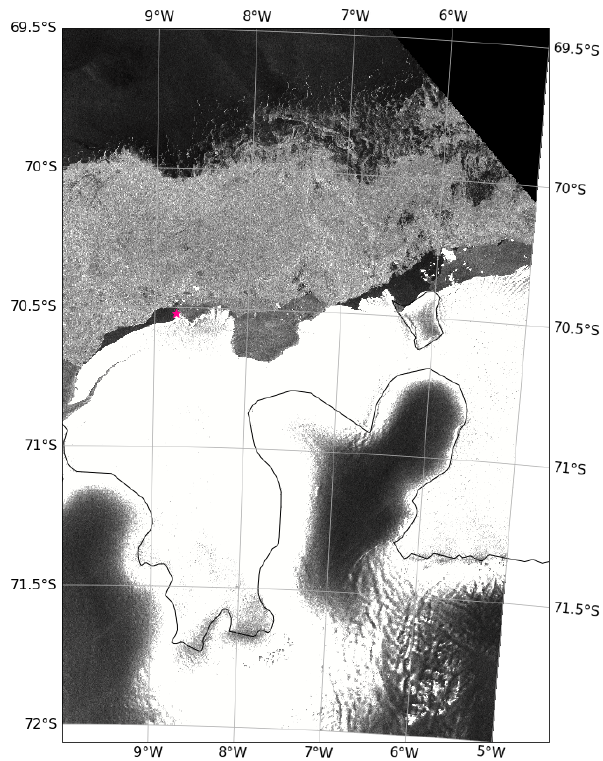
Figure A3. Sentinel-1 SAR image of the Ekström Ice Shelf and polynya on 10 January 2019 (PS117) (ESA, 2021). The pink star indicates the sampling location for the PS117 tidal